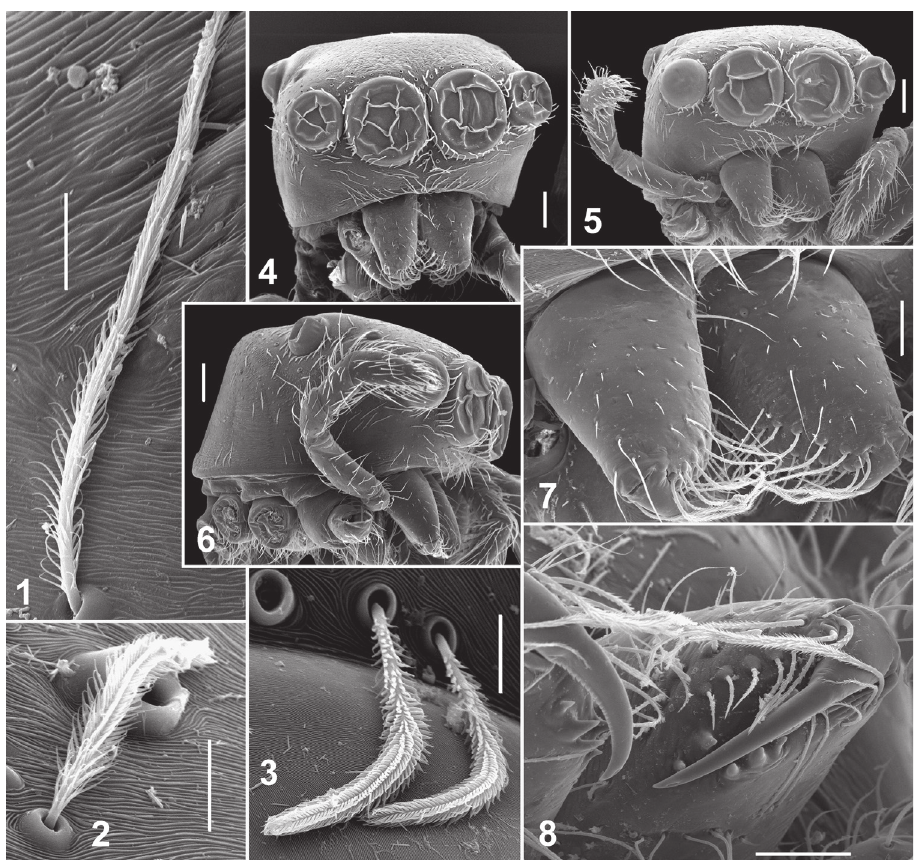
Figures 1–8. Somatic characters of Eupoa lehtineni sp. n. 1–3 plumose scales on female carapace. 4